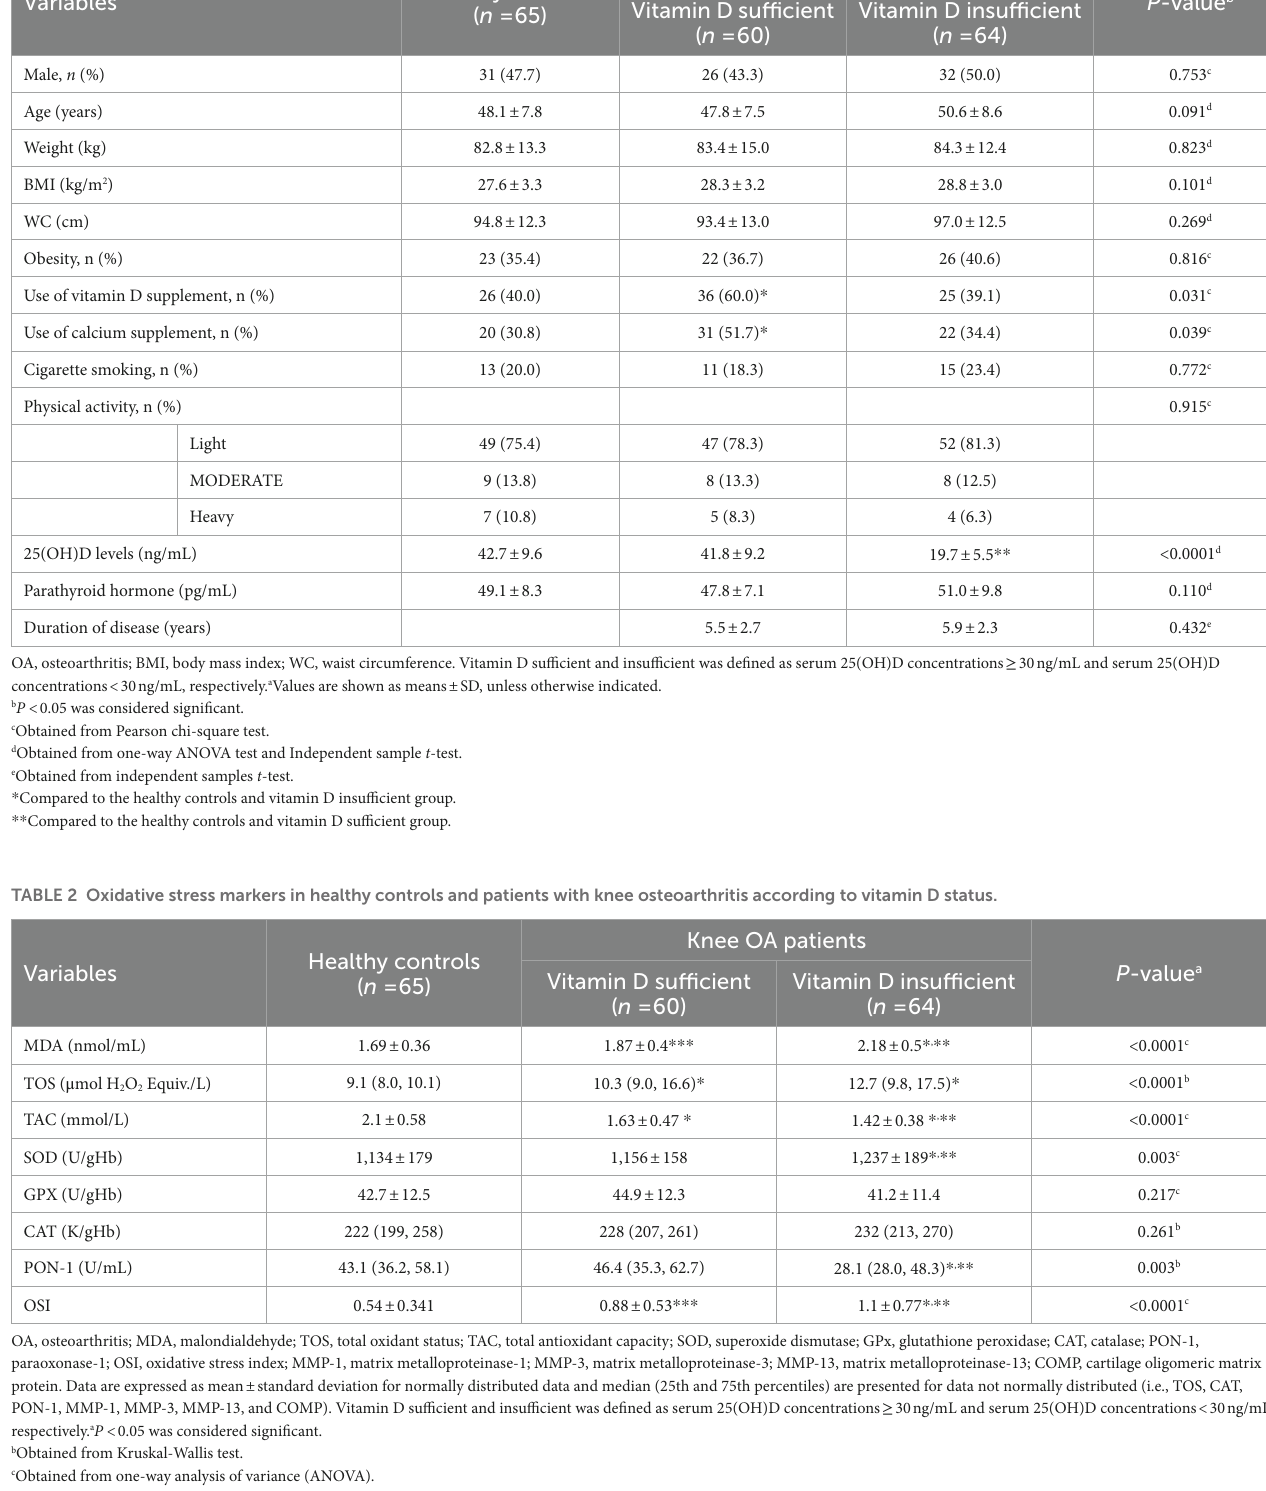
TABLE 1 General characteristics of healthy controls and patients with knee osteoarthritis according to the vitamin D status. a